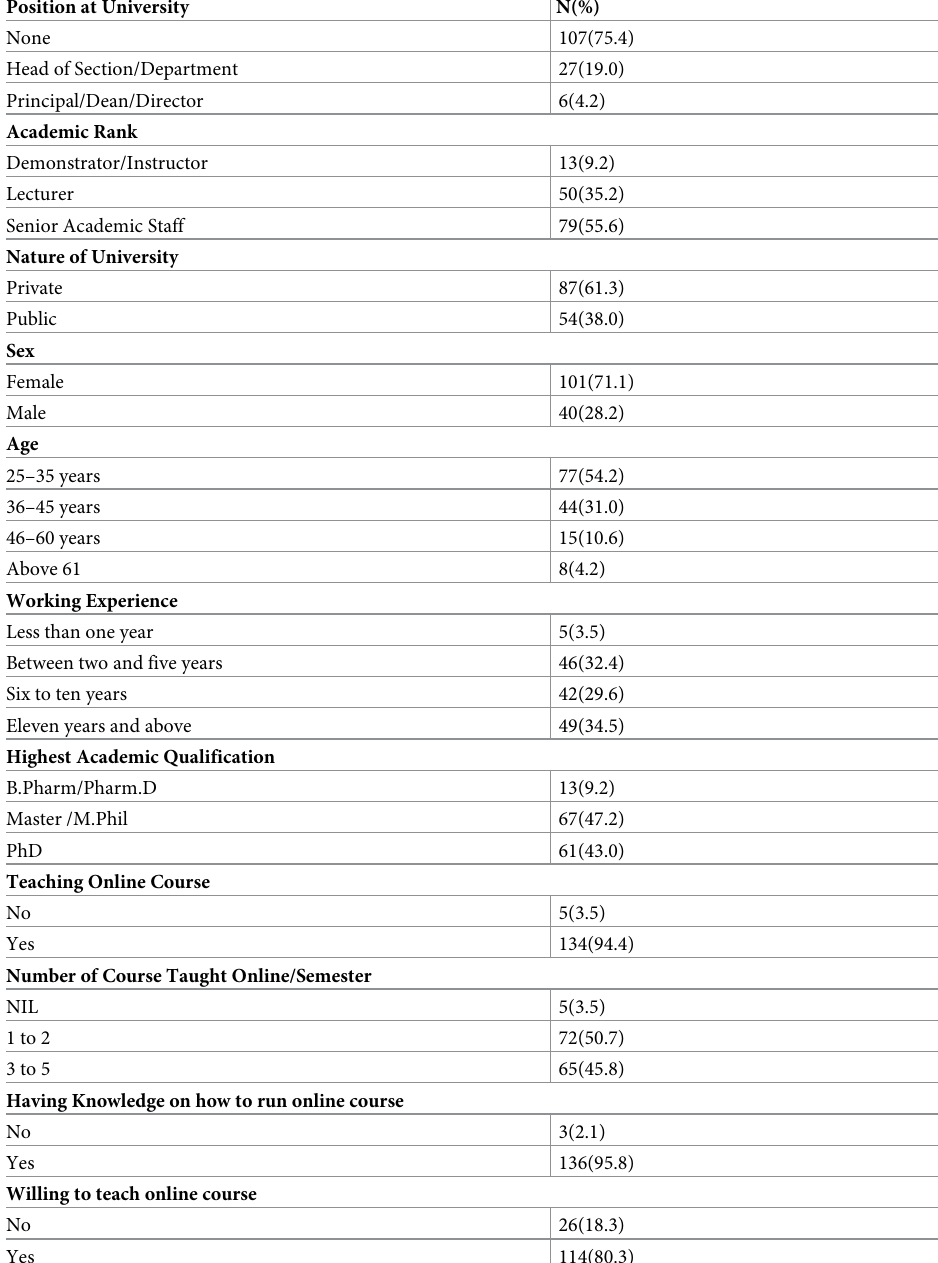
Table 1. Details of the pharmacy faculty participated in the survey (n =